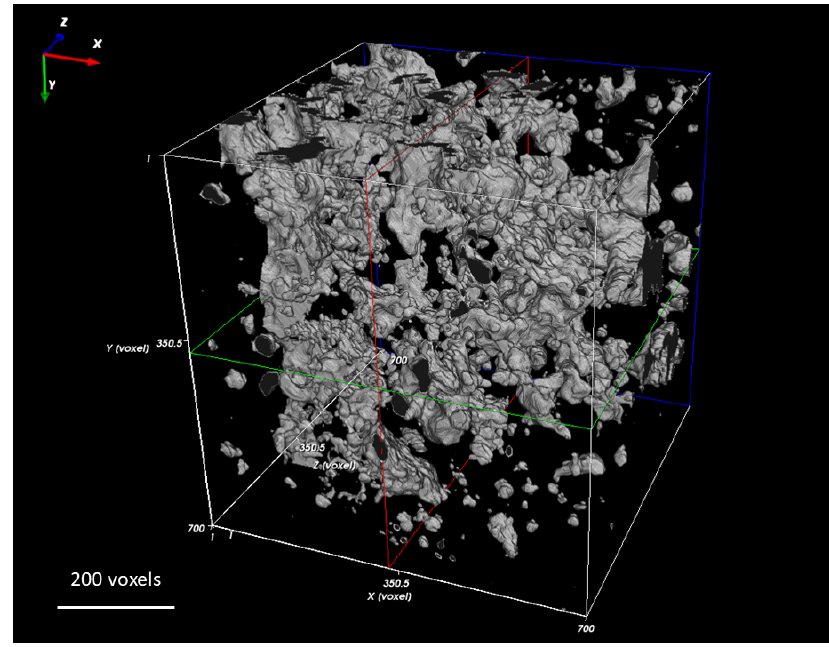
Figure 5. Pore space of tight dolostones (sample 61), poROSE software.